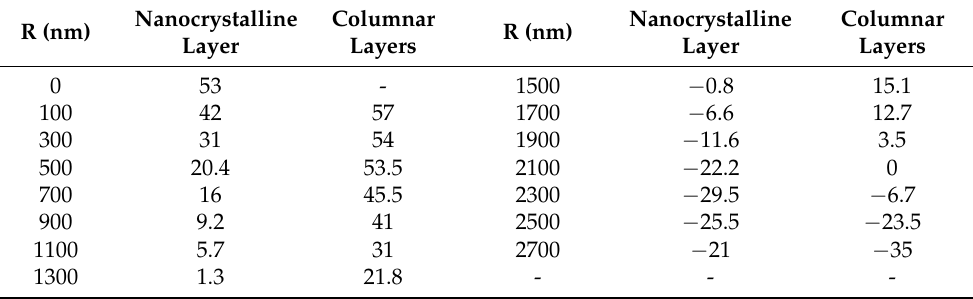
Figure 7. Bright-field image of the structure in the transverse cross-section of the indent. ( a ) General view. ( b ) Zoomed-in image of the region under the indenter’s tip; notations: 1—areas of fracture in nanocrystalline layer, 2—nanosized cracks. ( c ) Zoomed-in image of the indenter face; notations: 1—upper boundary of α -Ti layer, 2—upper boundary of columnar layer, S—substrate. Table 1. Values of coating layer deformation (%), which depend on the distance R from the inden- ter’s